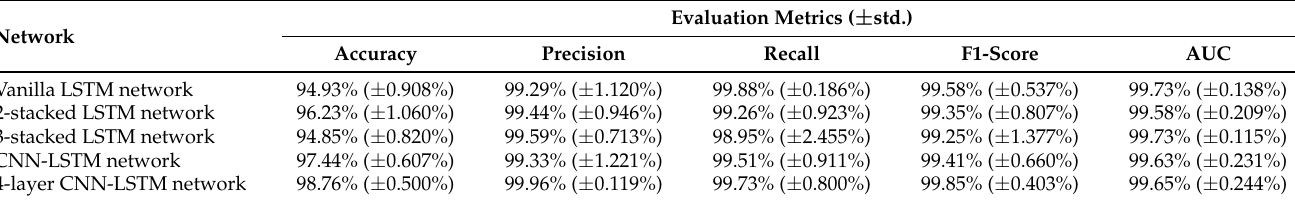
Table 9. Performance metrics of five LSTM networks used in the experiment by NOW sample generation and 10-fold cross validation